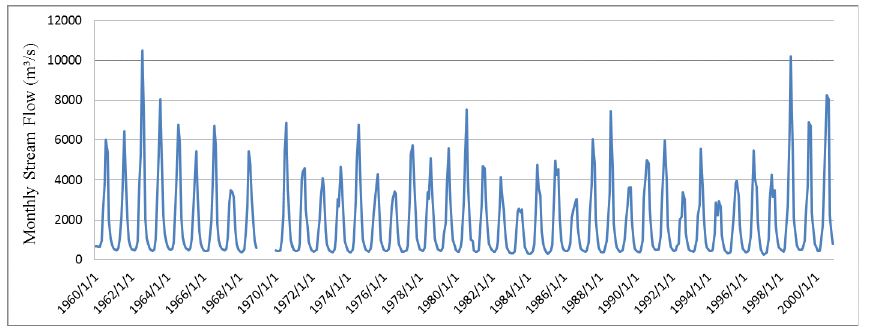
Fig 2. Monthly streamflow observations at Nuxia hydrological station from 1960 to 2000.